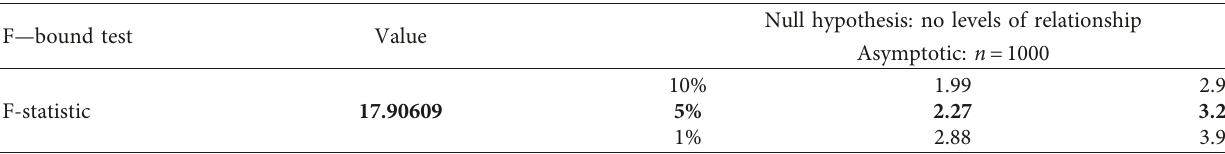
Figure 3: Results of Akaike information criterion from top 20 models. Source: authors’ own computation. Table 4: Results of the ARDL bound test.